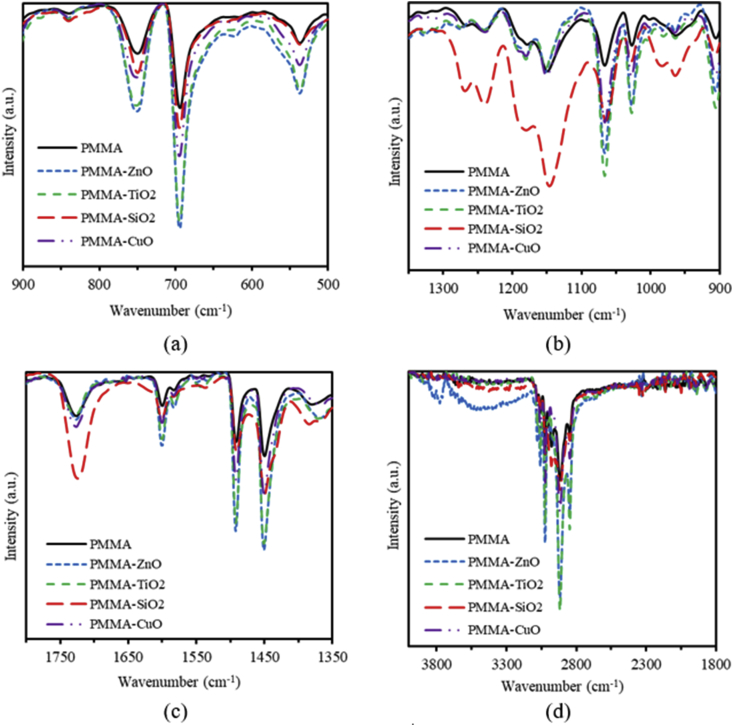
The FTIR spectra pure PMMA, and PMMA incorporated with ZnO, TiO2, SiO2 and CuO NPs nanocomposites: (a) 500-900 cm−1, (b) 900-1350 cm−1, (c) 1350-1800 cm−1 and (d) 1800-3500 cm−1.